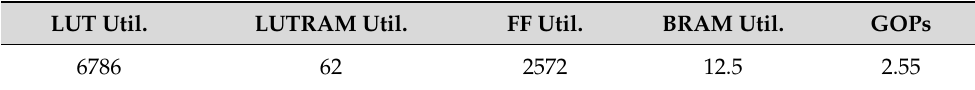
Table 8. HW resources and performances for our FPGA implementation. LUT Util. LUTRAM